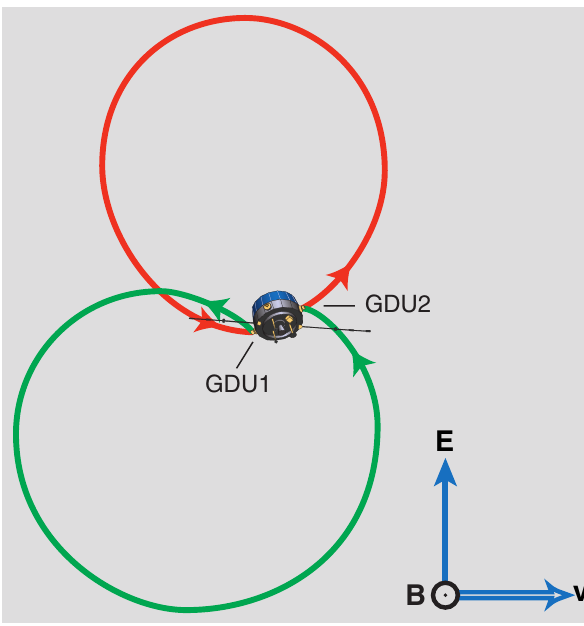
Fig. 2. Synthesis of the FGM and STAFF magnetometer data that EDI receives on-board over the Inter-Experiment Link (IEL). The top panel shows the raw FGM data, received at 16 samples/s, which appears as a stair-case because it is sampled here every 4ms. The bottom panel shows the combined (and rotated) data, which illus- trates the success of the synthesis method explained in the text. The plot uses the spacecraft convention with X along the spin axis. The sinusoidal variation in the Y - and Z -components is due to the space- craft spin. The plot was made from data stored in EDI’s scratch- RAM and dumped with the special BM3 telemetry mode that Clus- ter